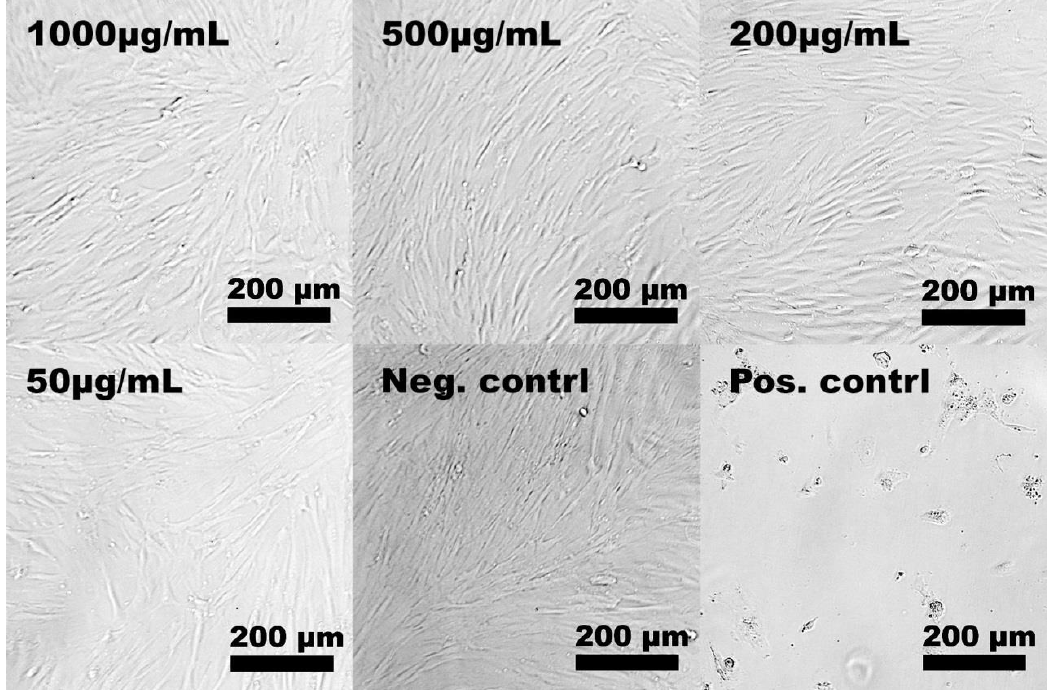
Figure 8. Representative light microscope images of hDF cells exposed to different particle concentrations of MMC for 48 h. The negative and the positive control samples represent untreated cells and cells that have been exposed to cell culture medium and 5% DMSO, respectively.